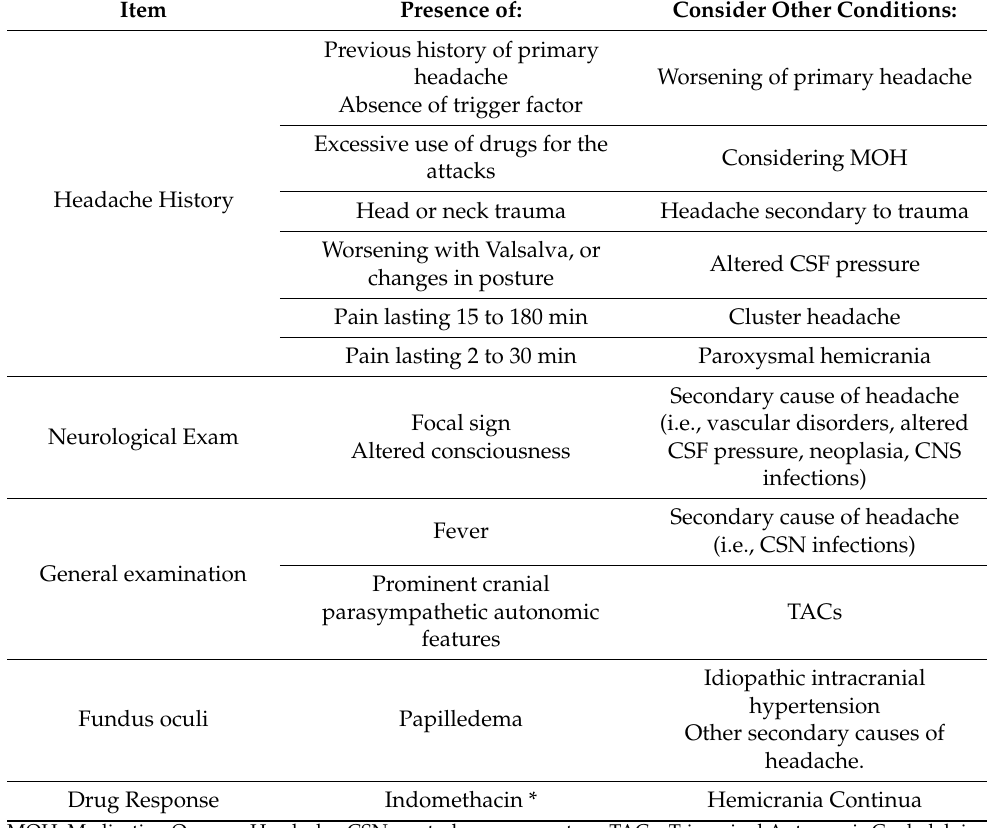
Table 2. Differential diagnosis of